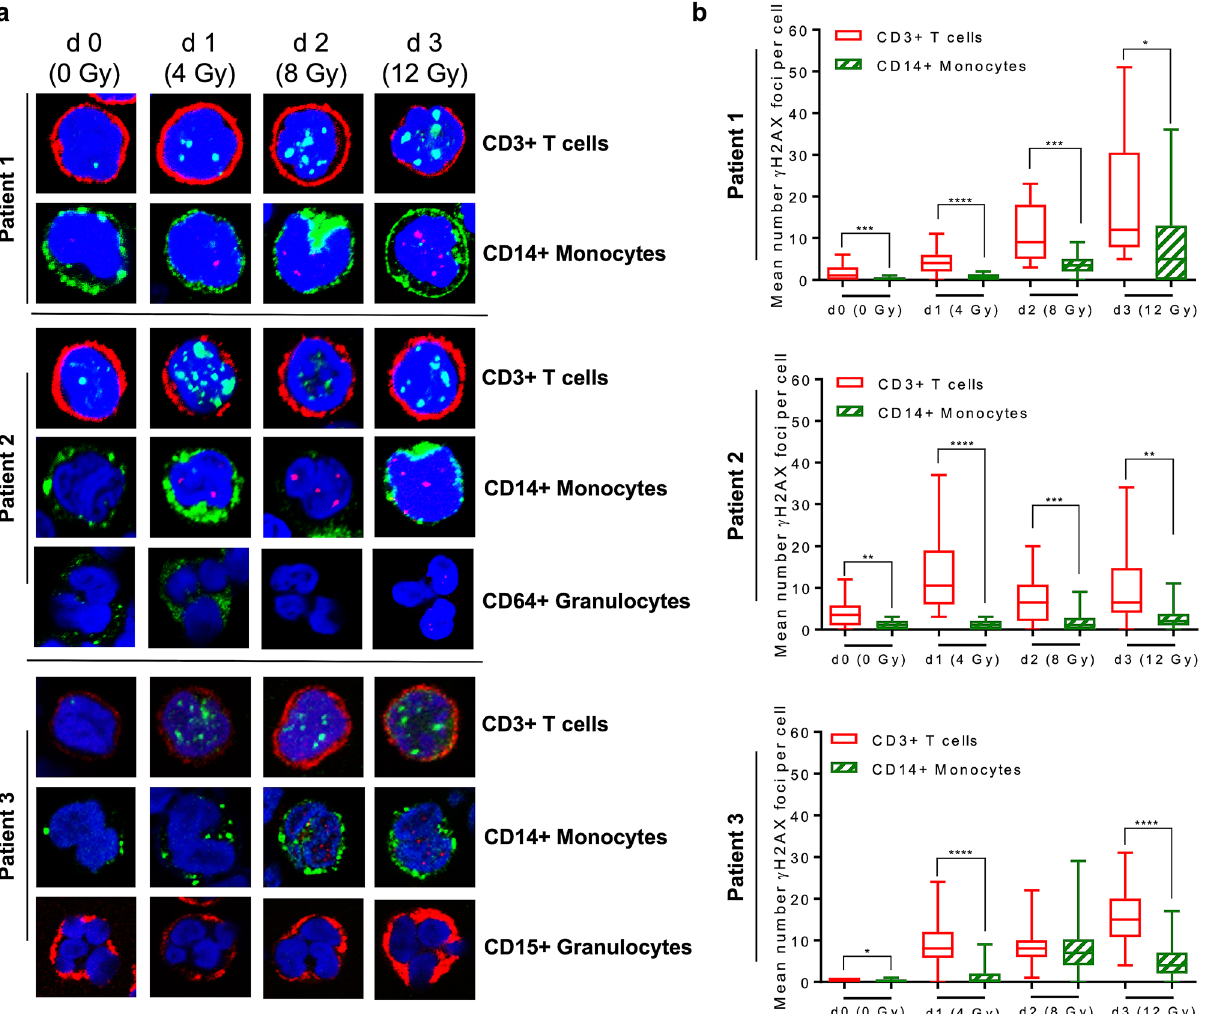
Figure 5. γH2AX staining in T cells (CD3+), monocytes (CD14+) and granulocytes (CD64+ or CD15+) isolated from patients during total-body radiation. ( a ) Representative images are shown of γH2AX foci (red or green) and CD surface marker (green or red) of PBMC at day 0 up to day 3 obtained from three different patients. Similar to what we observed for ex vivo irradiated granulocytes obtained from peripheral blood, no γH2AX foci could be detected in granulocytes upon exposure to ionising radiation in vivo. ( b ) Quantification of γH2AX foci in T cells and monocytes. In T cells significantly more γH2AX foci were induced following 3 each data set 50 cells). Box plots, t-test, * p < 0.05, ** p < 0.01, *** p < 0.001, **** p <